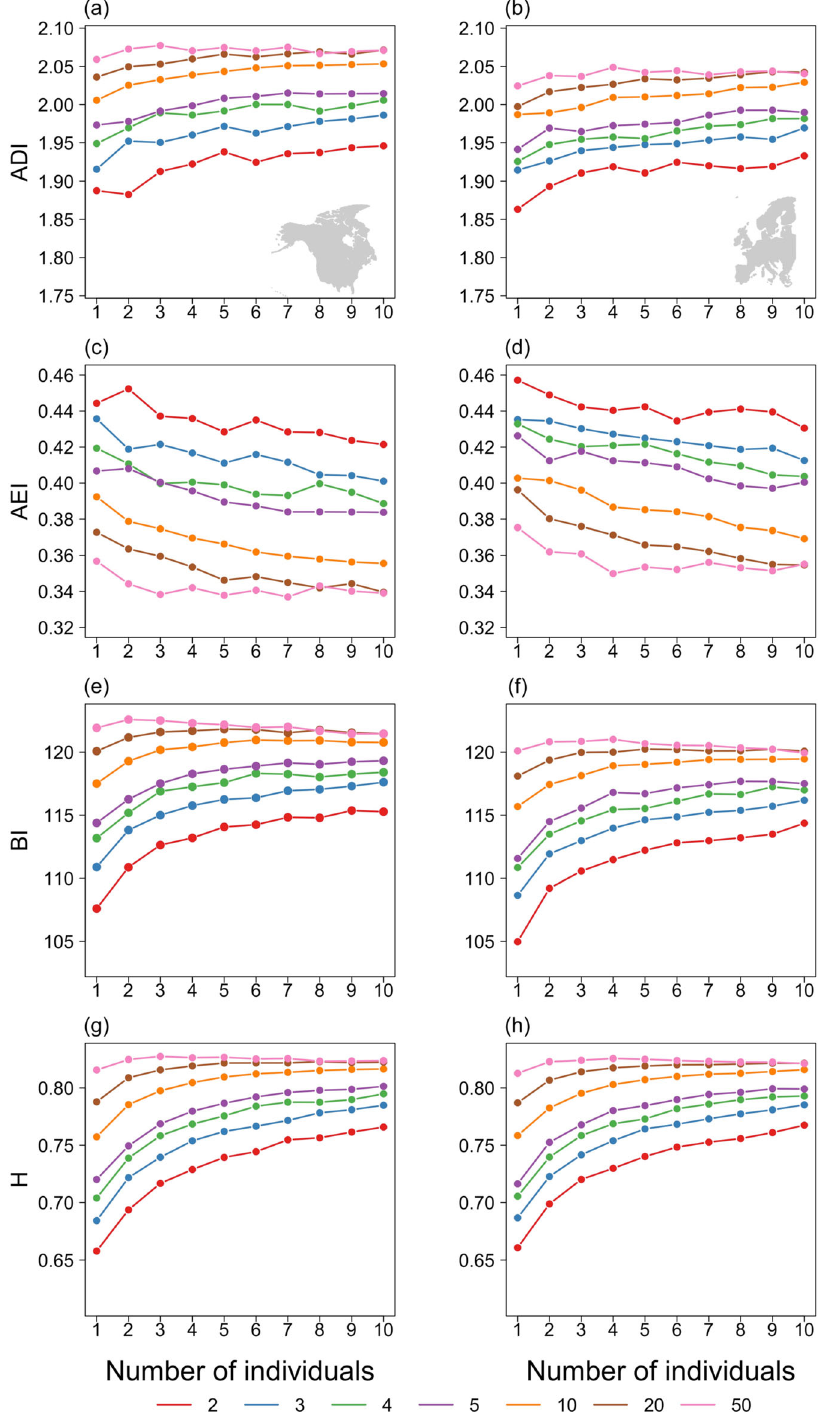
Fig. 2 Responses of acoustic indices to changes in simulated community structure. The association between the Acoustic Diversity Index, ADI ( a , b ), Acoustic Evenness Index, AEI ( c , d ), Bioacoustic Index, BI ( e , f ) and Acoustic Entropy, H ( g , h ) of constructed soundscapes and the number of individuals and species contributing to that soundscape for North American (left column) and European (right column) species. Colours indicate the number of species in the